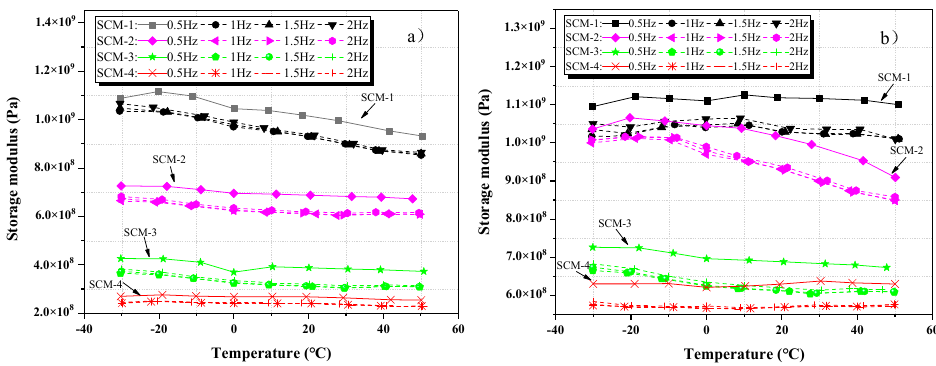
Figure 6. Relationship between the storage modulus and temperature of SCM-1, SCM-2, SCM-3, and SCM-4 at varying frequencies: ( a ) 7 days; ( b ) 28 days.